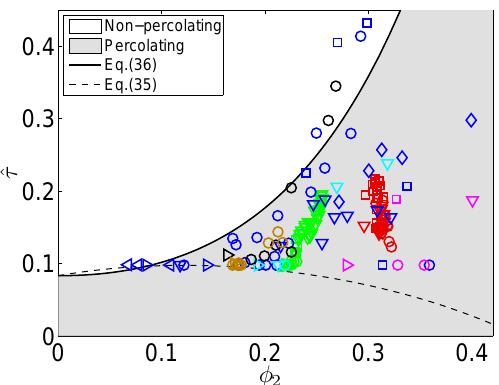
Figure 5. Estimated stickiness values ˆ τ as a function of ice vol- ume fraction φ 2 . Experiment series are indicated by colors (TGM- 17: red, TGM-2: green, DIV: blue, DH-1: magenta, DH-2: cyan, ISO-1: black, ISO-5: brown) and snow types by markers (PP: (cid:67) , DF: (cid:66) , RG: ◦ , FC: (cid:3) , DH: ∨ , MF: (cid:5)